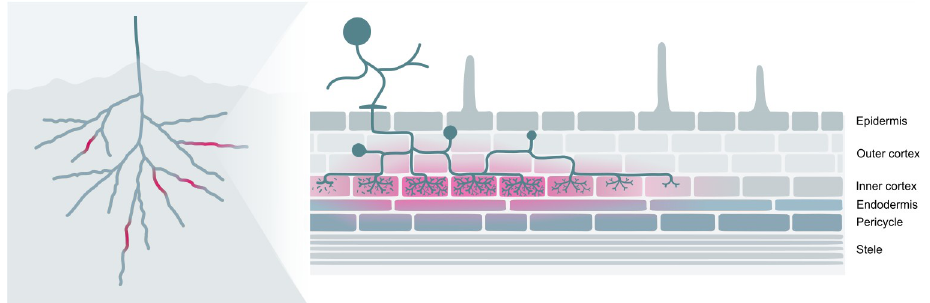
Fig 9. Betalains can be used as markers for AM colonisation in plant roots. Left: Red pigmentation is easily observable in whole plant root systems. Right: Red pigmentation is most prominent in colonised tissues as well as in adjacent tissue